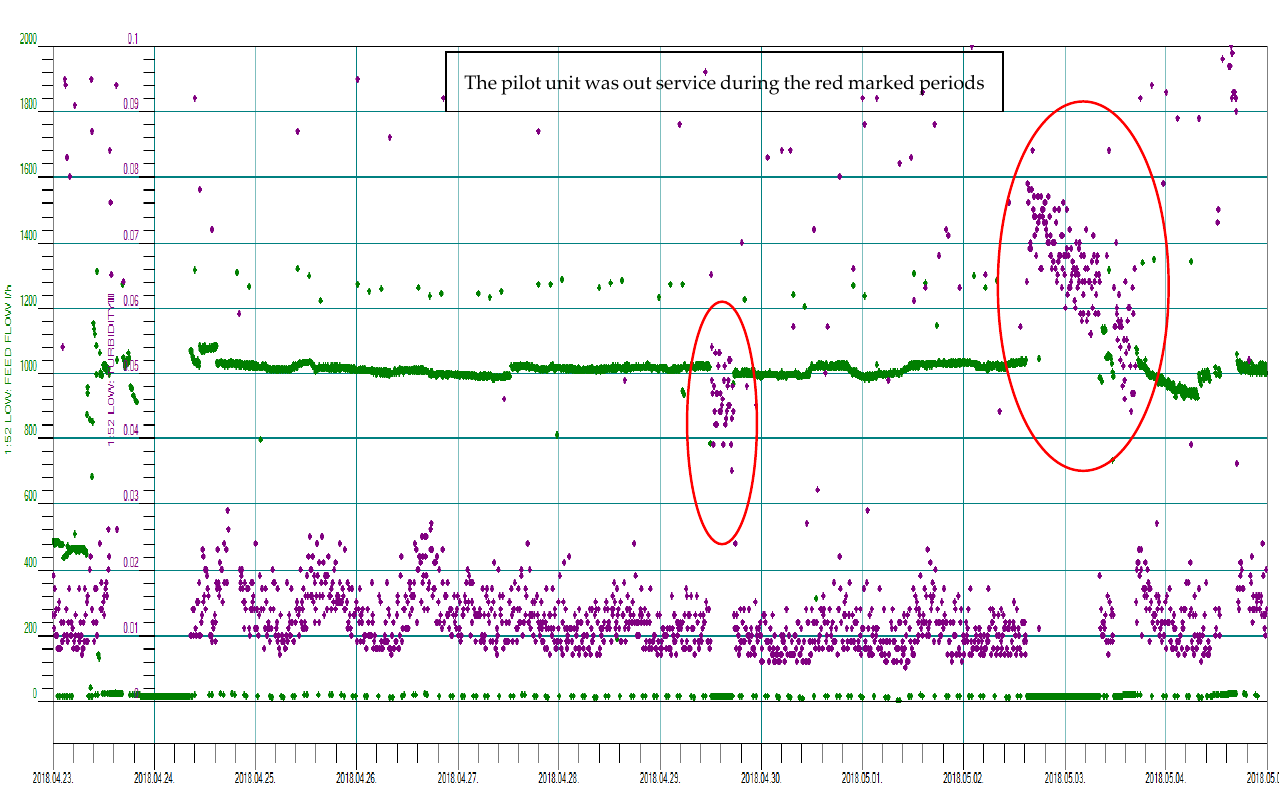
Figure A9. Flow and TMP with bentonite dosing.